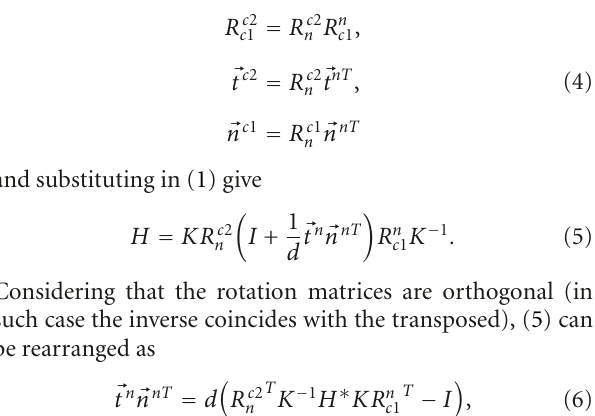
Figure 3: (a) displays the set of features tracked with the KLT algorithm. In (b) the outlier feature set has been identified and removed using the RANSAC